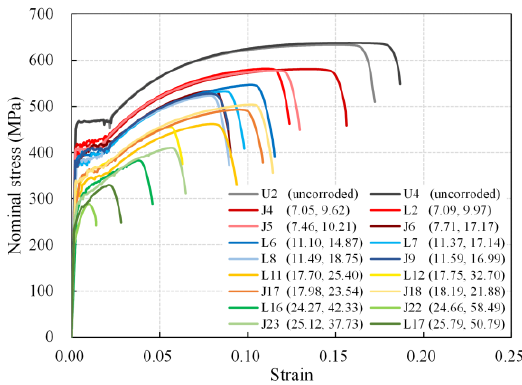
Figure 9. Nominal stress – strain curves of steel rebars. Table 4. Comparison of tensile properties of corroded rebars with similar average corrosion de- grees.